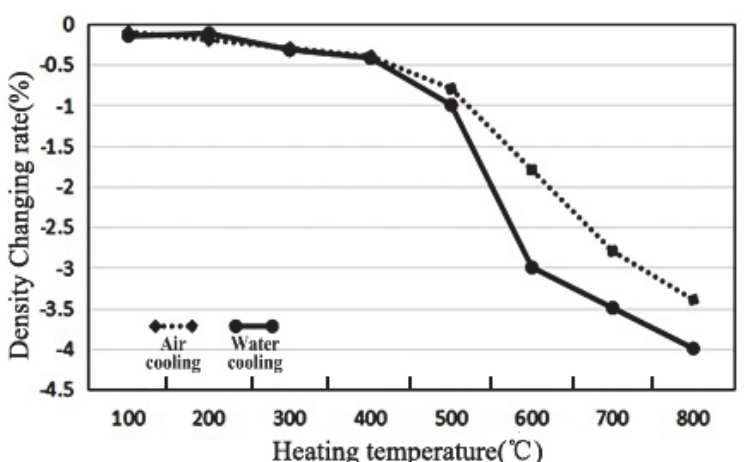
Figure 4: Density changing rate after